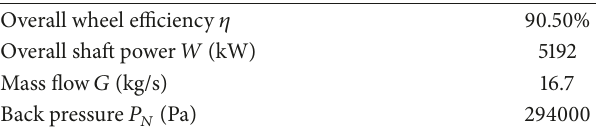
Table 3: The main aerodynamic parameters of overall centrifugal